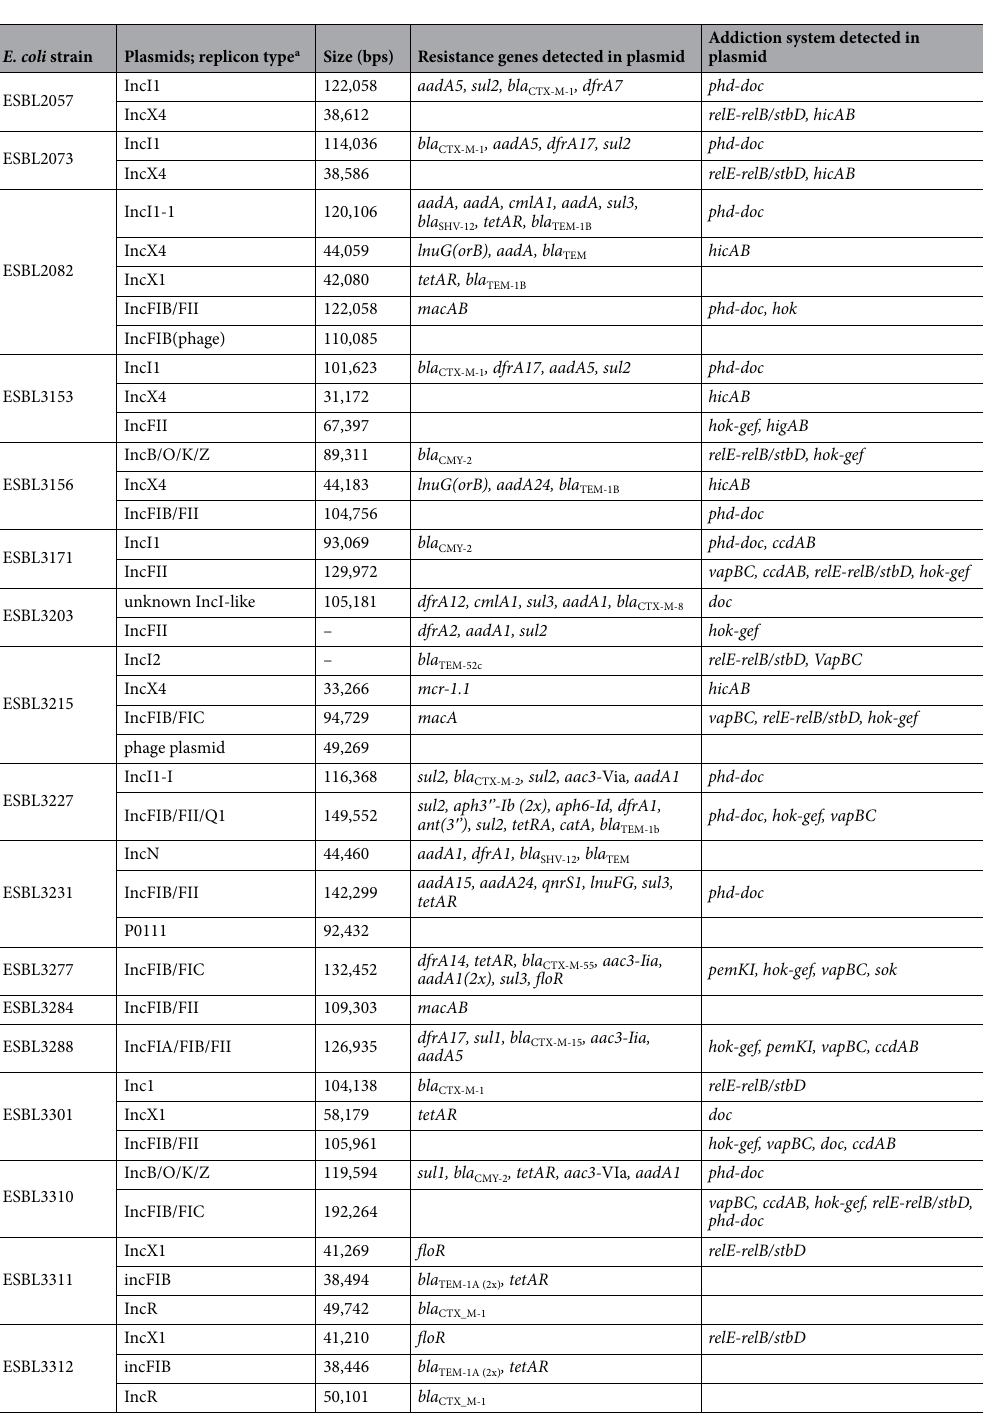
Table 1. Plasmid/replicon types shown per E. coli strain with corresponding size, resistance genes and addiction systems. Missing plasmid sizes are due imperfect assemblies that make a correct estimation of the plasmid impossible. a Multiple replicon types in one row means a plasmid contains all these